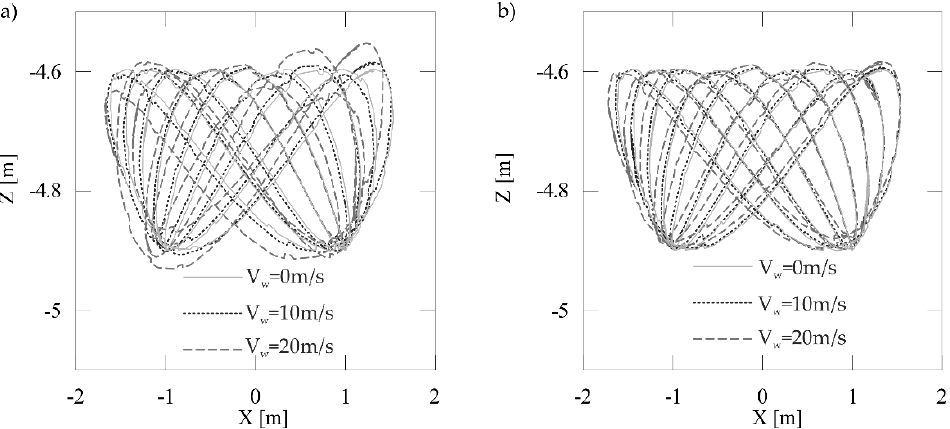
Figure 14. Projection of the trajectory of the carried load’s suspension point on one of the lifting planes for ( a ) the variable effective area and ( b ) fixed effective area.